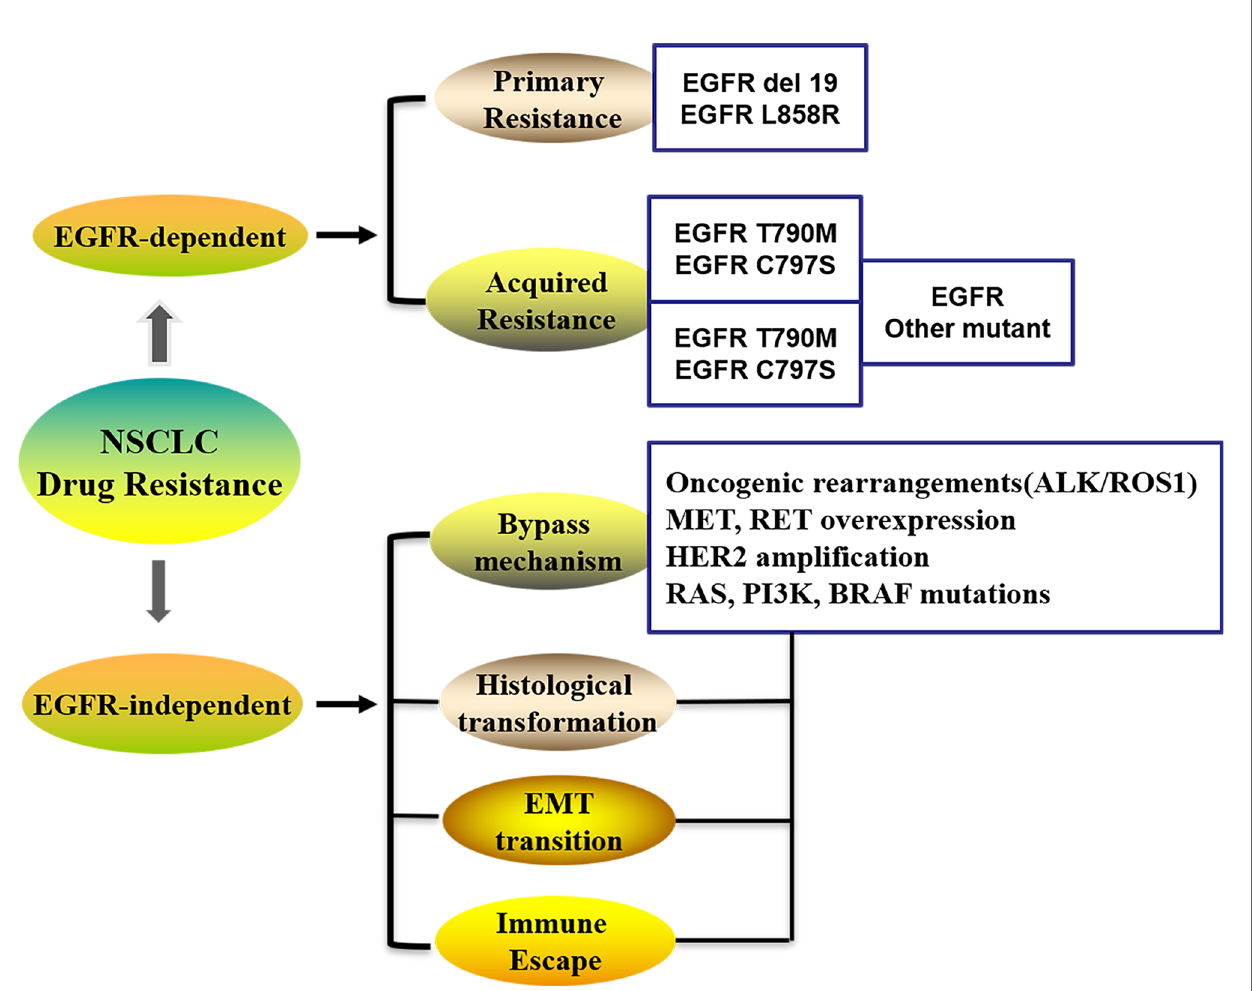
FIGURE 1 | The patterns in the development of drug-resistance NSCLC. NSCLC, Non-small cell lung cancer; EGFR, Epidermal growth factor receptor; EMT, Epithelial – mesenchymal transition; ALK, Anaplastic lymphoma kinase; ROS1, receptor tyrosine kinase; Her-2, Human epidermal growth factor; PI3K, phosphatidylinositol ‐ 3 ‐ kinase; RAS, Rat sarcoma; MET, Proto-oncogene receptor tyrosine kinase; RET, Rearranged during transfection; BRAF, B-Raf